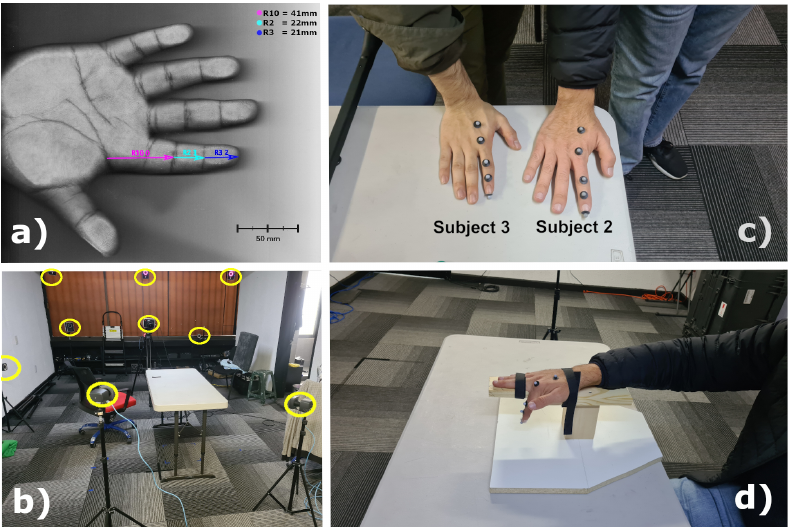
Figure 3. ( a ) Image illustrating how the finger measurements are taken. ( b ) Infrared Camera Layout. ( c ) Location of the markers during MOCAP experiments. ( d ) Device used for resting the palm and forearm during experiments to guarantee consistency of the finger